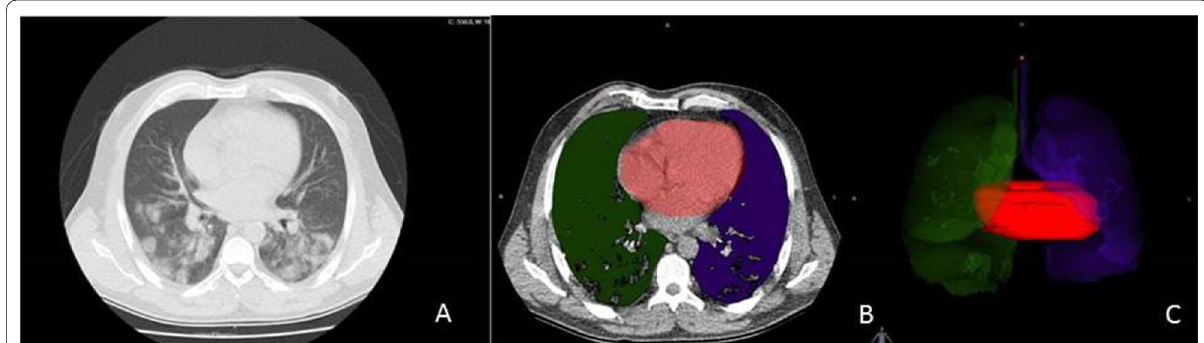
Fig. 1. 3D planning of thoracic organs by Myrian ® software: A The transverse plane of thorax tomography, B the color scale of left (blue) and right (green) lung, and heart (pink), C 3-D plan of thorax tomography by Myrian ® software